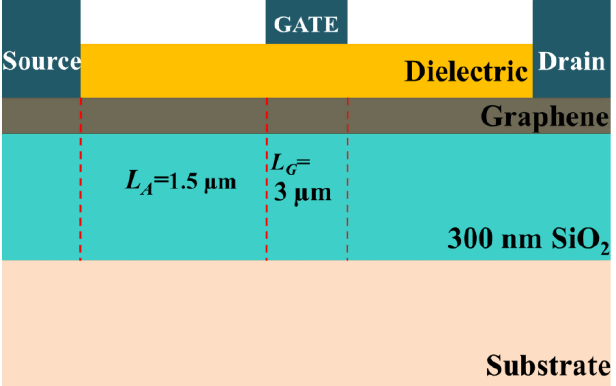
Figure 5. Schematic of baseline GFET-1 (not to scale).